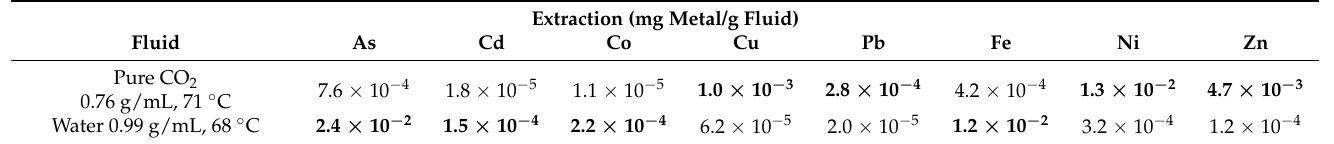
Table 5. Comparison of extraction in two cases: pure CO 2 and pure water. Bold characters indicate the higher solubility between the two solvents. From